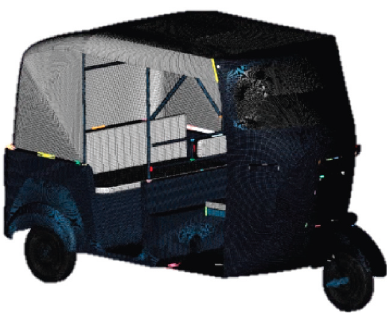
Figure 4: FEA methodology.